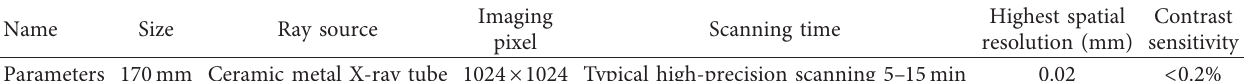
Table 2: Main technical parameters of the 225kV X-ray industrial